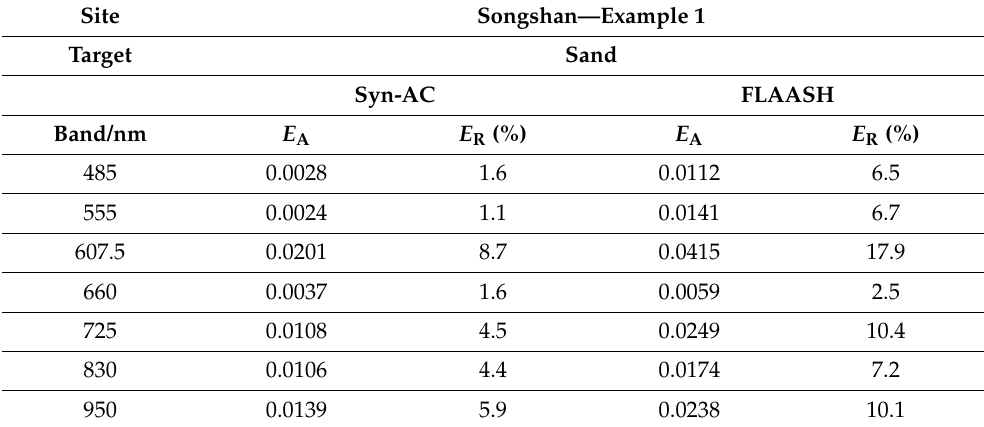
Table 8. Performance comparison for sand between Syn-AC and FLAASH, based on Example 1.